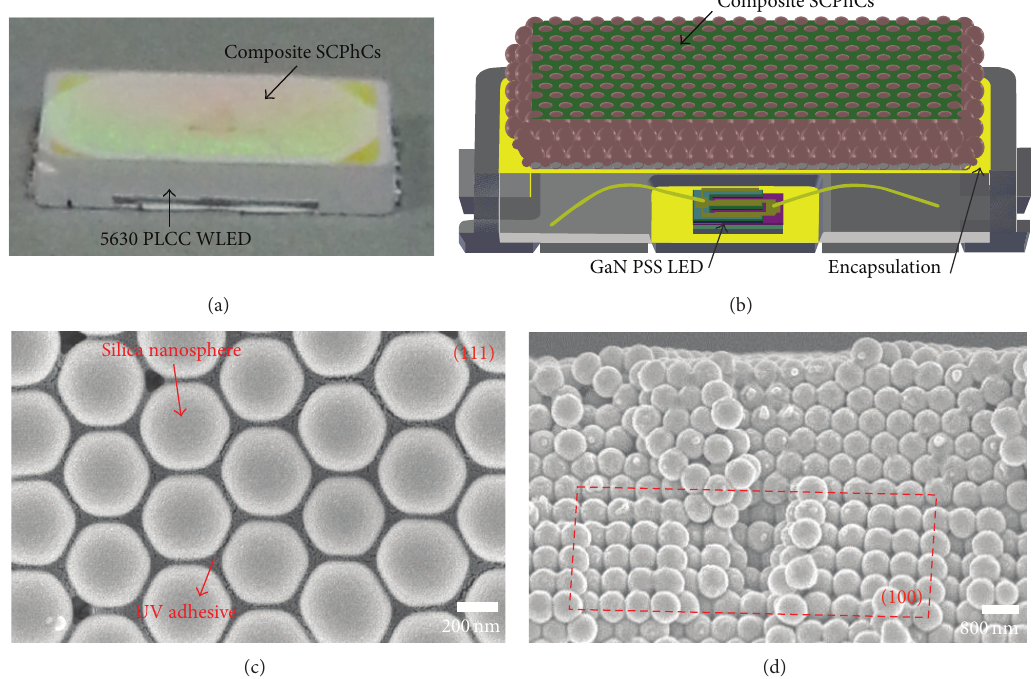
Figure 1: (a) Optical microscopy image and (b) schematic diagram of the c -SCPhCs deposited onto the 5630-type PLCC-packaged WLEDs. FESEM images of the c -SCPhCs prepared using silica nanospheres with a diameter of 400 nm; (c) and (d) display a well-organized (111) plane and (100) plane of face-centered cubic